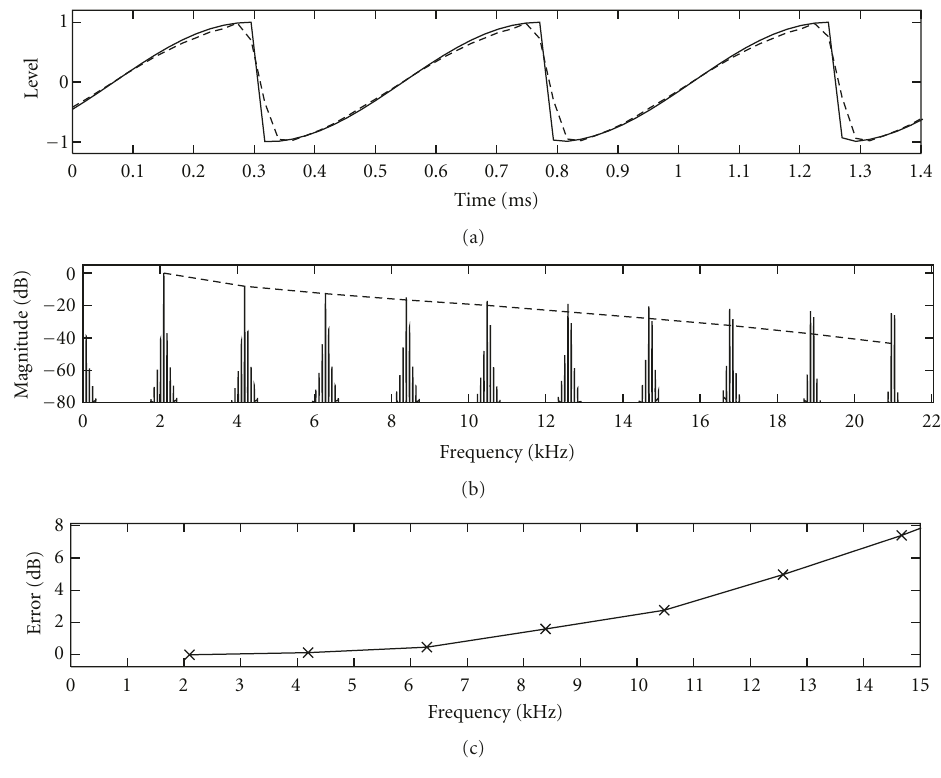
Figure 6: (a) Waveform, (b) the spectrum, and (c) the harmonic magnitude error of the PD model of the Moog sawtooth oscillator output at f 0 = 2 . 096kHz. The waveform and the spectral envelope of the recorded signal are again drawn with dashed line in (a) and (b), respectively.